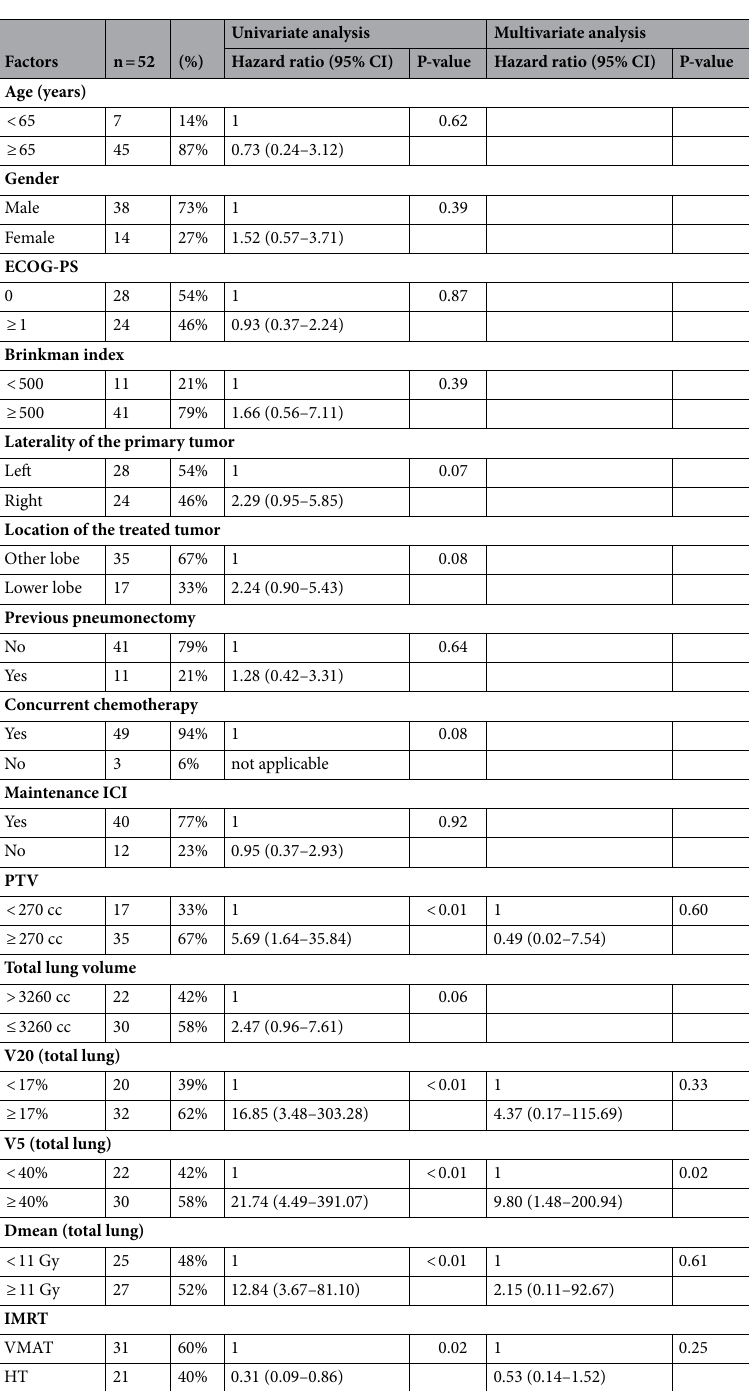
Table 2. Univariate and multivariate analyses for occurrence of grade ≥ 2 radiation pneumonitis. CI confidence interval, ECOG-PS Eastern Cooperative Oncology Group performance status, ICI immune checkpoint inhibitor, PTV planning target volume, V20 lung volume receiving a dose of ≥ 20 Gy, V5 lung volume receiving a dose of ≥ 5 Gy, Dmean mean dose, IMRT intensity-modulated arc therapy, VMAT volumetric modulated arc therapy, HT helical